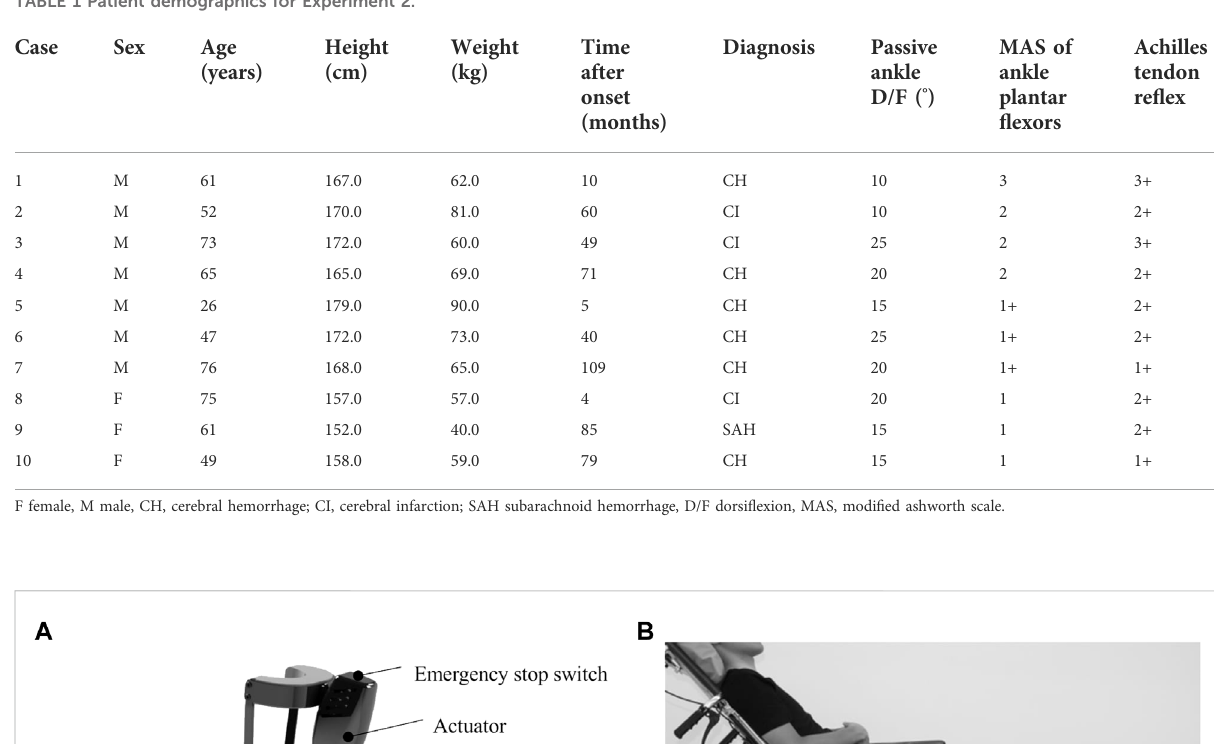
TABLE 1 Patient demographics for Experiment 2.